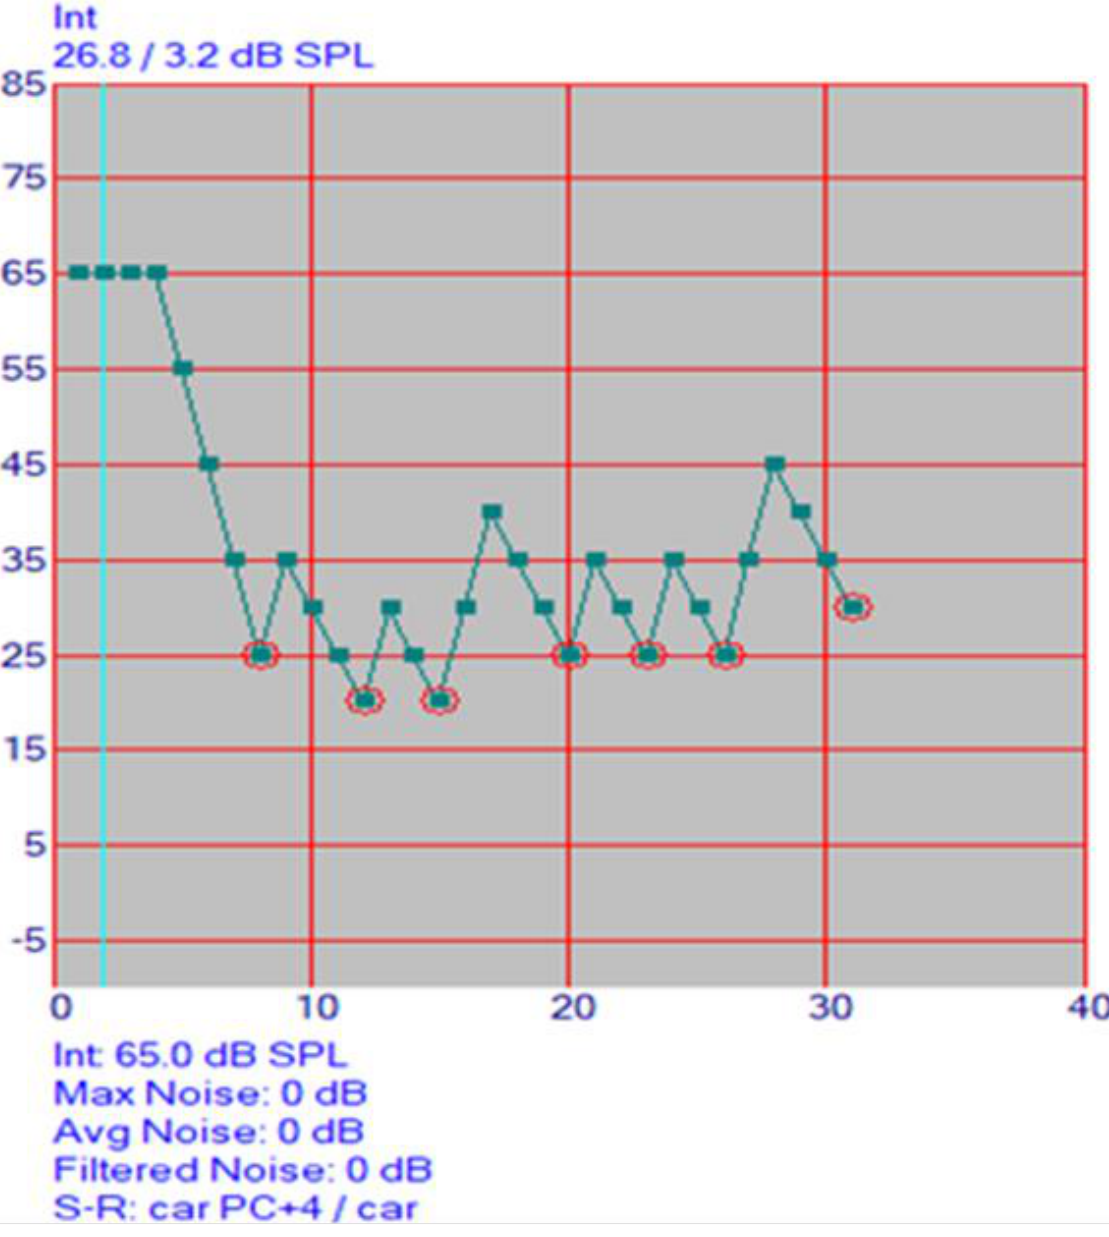
Figure 6. AAST result interface .